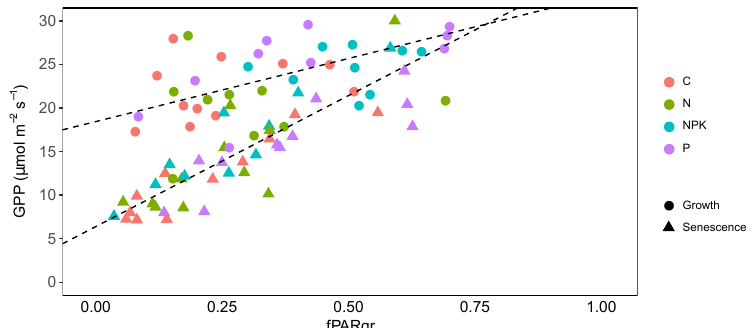
Figure 4. Relationship between GPP and fPARgr observed in grassland subjected to different fertilization treatment (C, N, NPK and P). Measurements taken during the vegetation growth are indicated as circles (corresponding to measurement days 1 and 2), while those realized during the senescence period are indicated as triangles (measurement days 3 and 4). Linear regression lines were fitted separately to the two periods (GPP = 14 . 48fPARgr + 18 . 44, R 2 = 0 . 39, P < 0 . 001 and GPP = 30 . 08fPARgr + 6 . 39, R 2 = 0 . 65, P < 0 . 001, respectively for the growth and the senescence period).